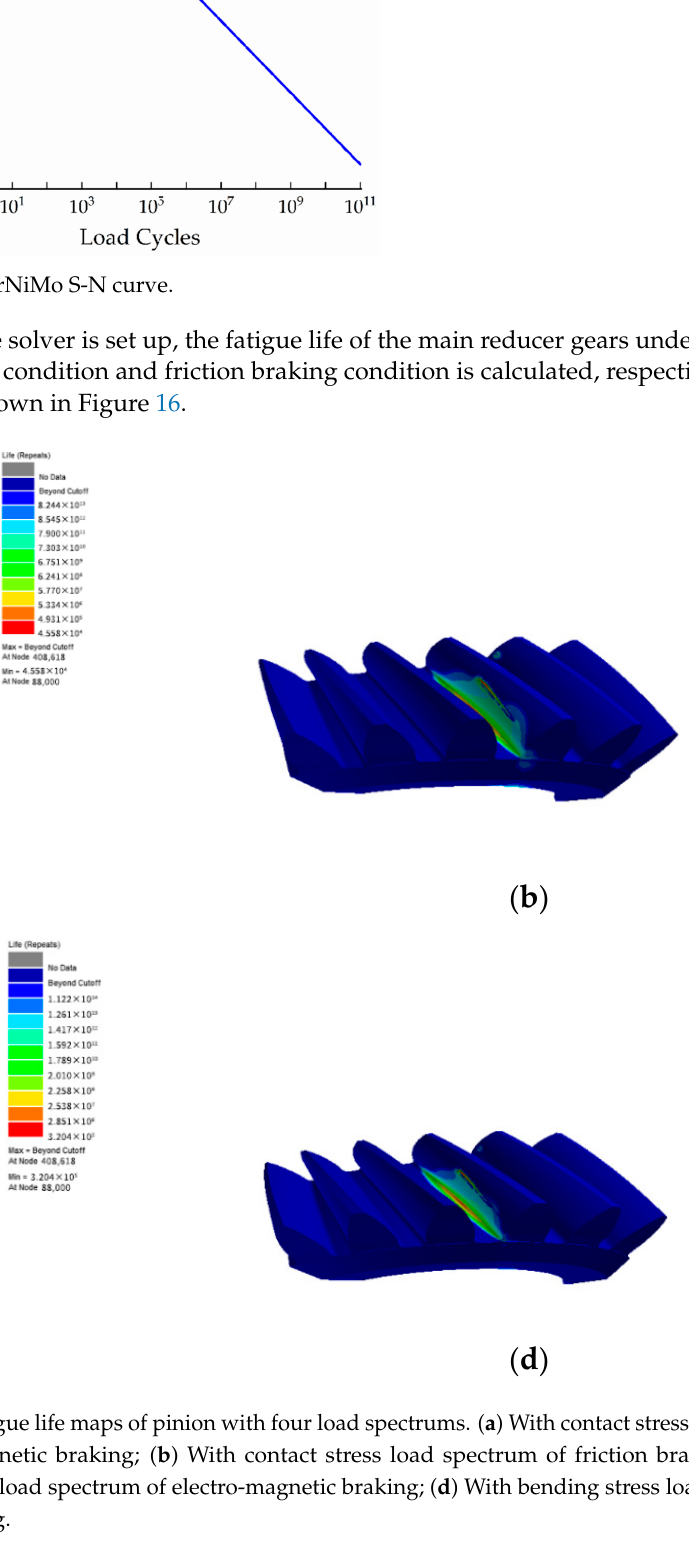
Figure 15. 20CrNiMo S-N curve.